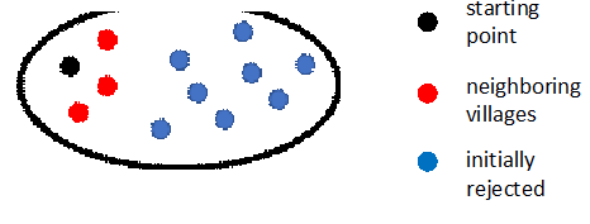
Figure 6: Genetic algorithm test